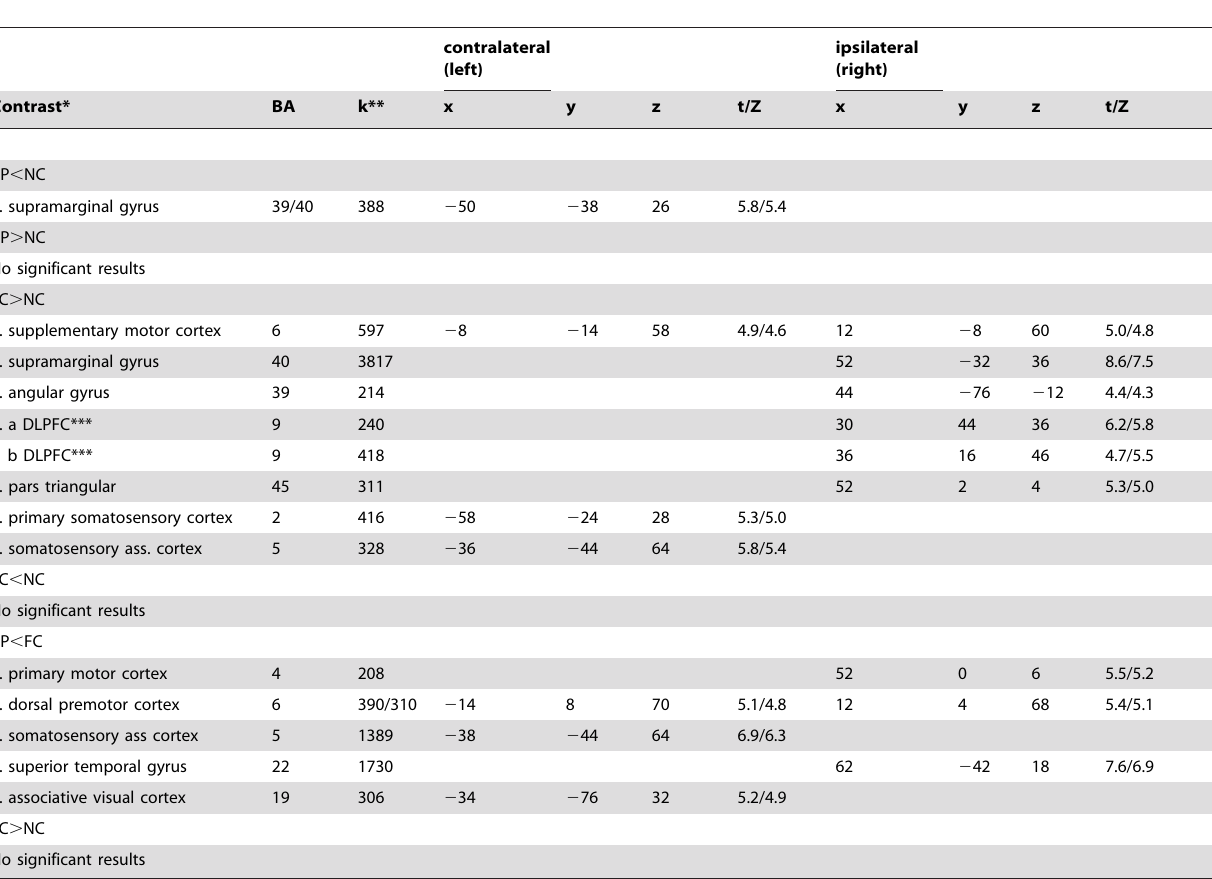
Table 7. Cerebral activation related to movement imagery on the affected hand (left-sided patients and feigners were flipped).